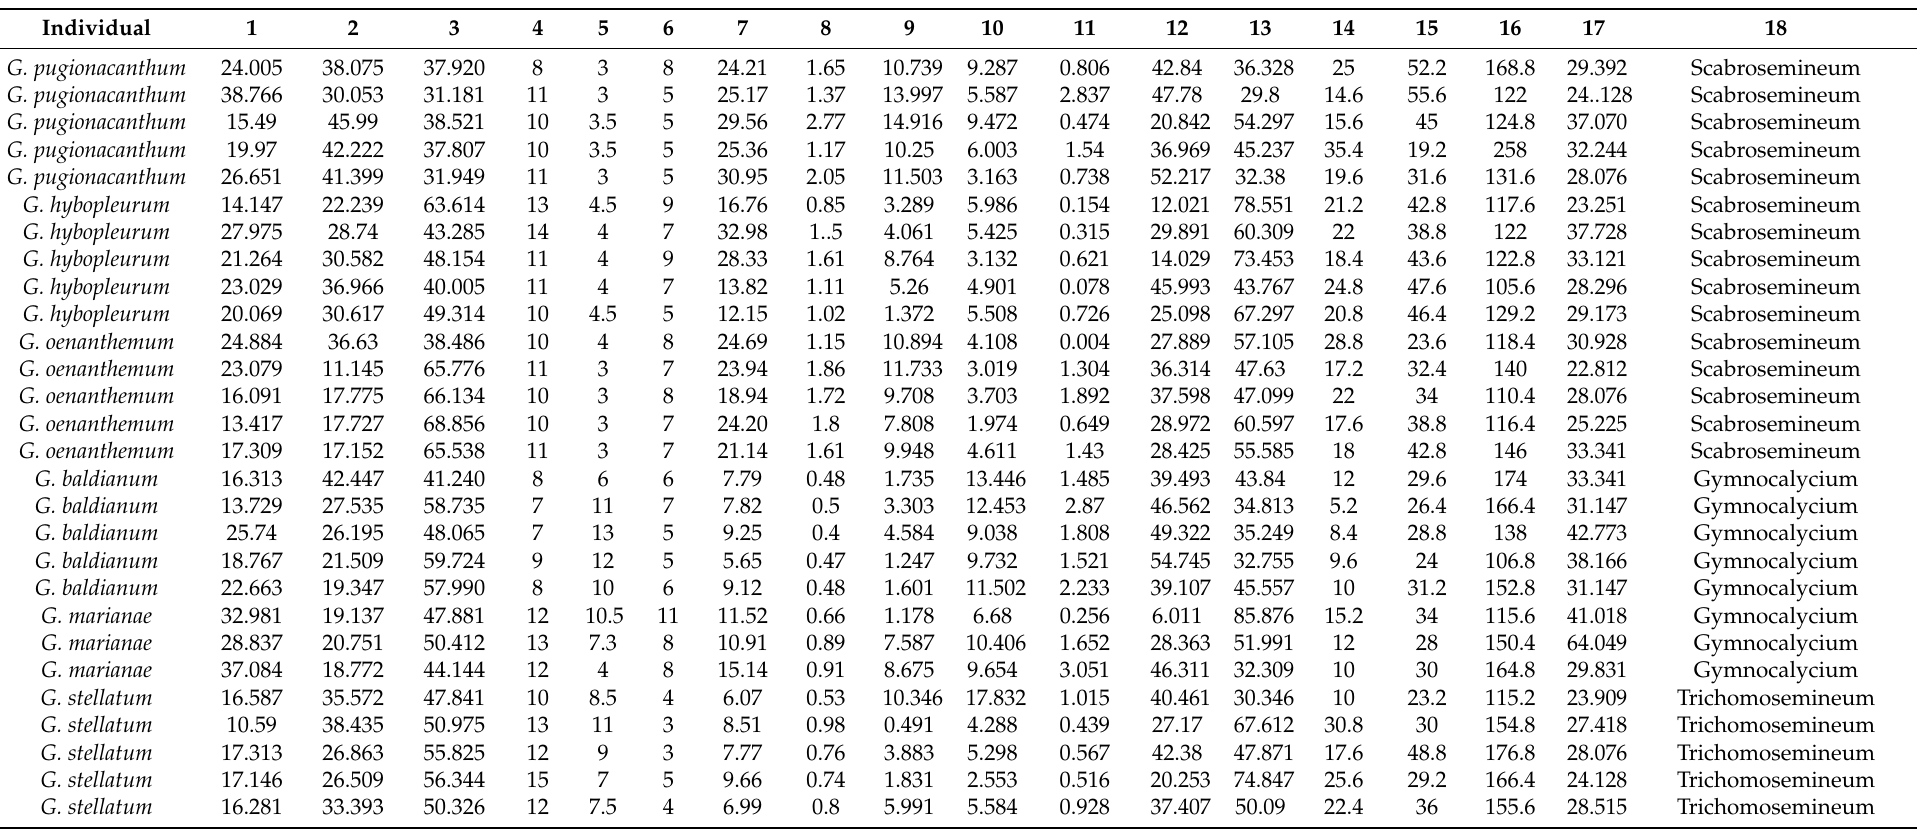
Table A1. Basic data matrix (BDM) for the principal component analysis (PCA): (1) aboveground stem (%); (2) underground stem (%); (3) root length (%); (4) number of ribs; (5) density of areola; (6) number of spines; (7) spine length (mm); (8) spine width (mm); (9) spine dry weight (%); (10) main root dry weight (%); (11)